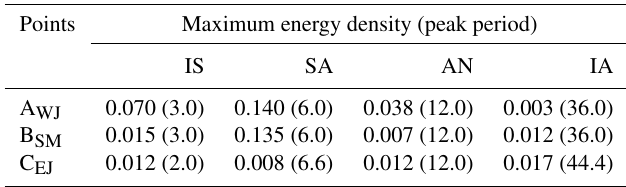
Table 3. Maximum energy density (peak energies) at intraseasonal, semiannual, annual, and interannual timescales at points A WJ , B SM , and C EJ